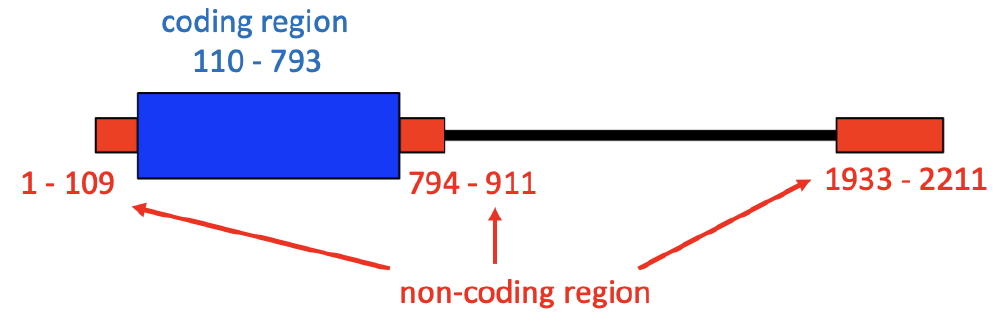
Figure 1. Schematic diagram of the aligned HDV genome. The three red rectangles indicate the non-coding regions. The numbers colored red indicate the positions of the non-coding regions in the alignment shown in Supplementary Data S1. The blue rectangle indicates the negative strand coding region of the L-HDAg gene. The numbers colored blue indicate the positions of the coding region in the alignment. The black line indicates the region that includes the complementary sites of the coding